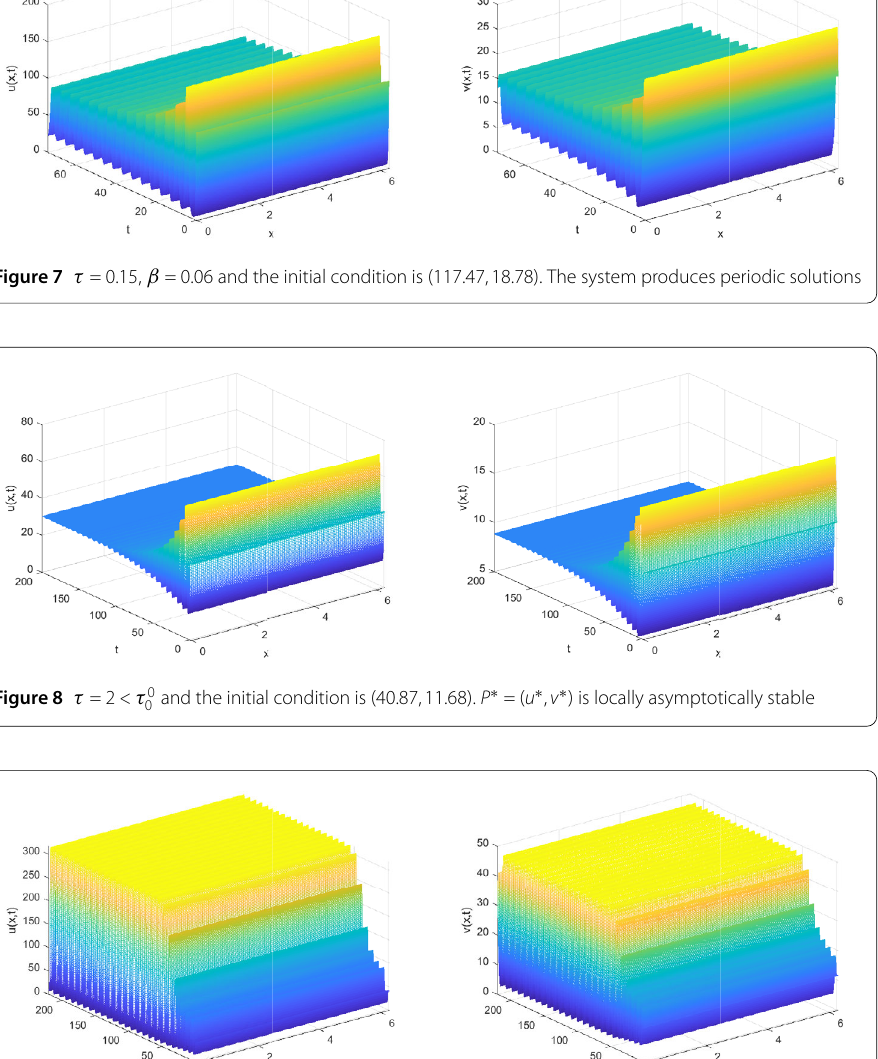
, the equilibrium P ∗ = ( u ∗ , v ∗ ) loses stability 0